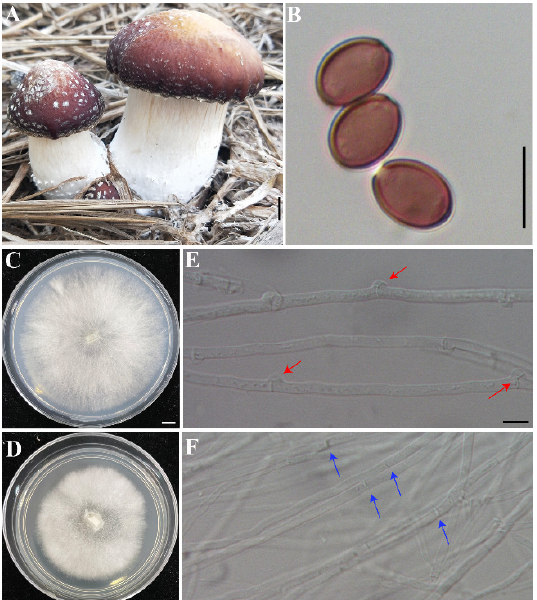
Figure 1. The fruiting bodies of Stropharia rugosoannulata and the monokaryotic strain used for genome sequencing. ( A ) The fruiting bodies of S. rugosoannulata . ( B ) The basidiospores of S. rugosoannulata . ( C , E ) Heterokaryotic mycelia with clamp connections. ( D , F ) Vegetative mycelium of monokaryotic strain S68. Bars: ( A , C , D ) = 1 cm; ( B , E , F ) = 10 μ m. A vegetative monokaryotic strain S68 derived from the “Heinong No. 1” strain was